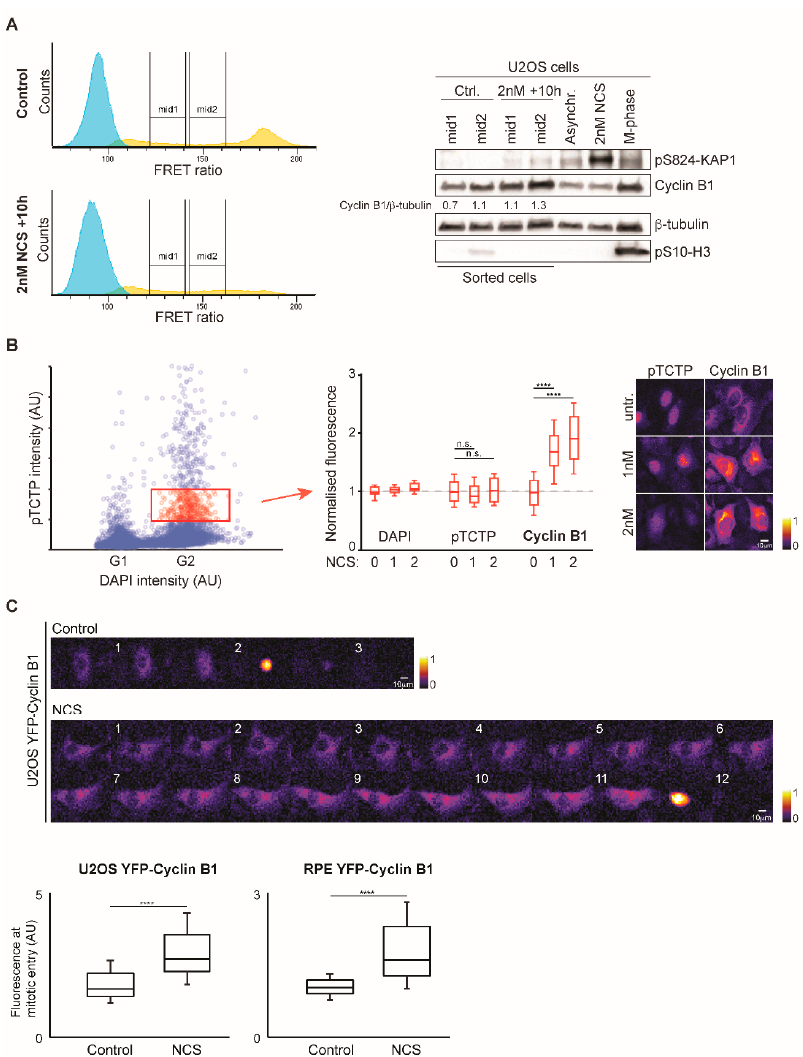
Figure 3. Cells recovering from a DNA damage checkpoint contain increased level of Cyclin B1. ( A ) 10 h after being exposed to 2 nM NCS, cells were sorted according to their level of PLK1 activity. Two fractions, defined “mid1” and “mid2”, were collected for both control and NCS-treated cells. All samples were treated with 10 μ M S-trityl-L-cysteine (STLC) 4 h before the sorting. After the sorting, cells were pelleted, lysed in Laemmli sample buffer and analyzed by Western blot. Unsorted cells, either untreated, treated with 2 nM NCS or treated with 10 μ M STLC and subjected to mitotic shake off were included as a reference. Phosphorylation of histone H3 was used as a marker of mitotic cells, whereas phosphorylation of KAP1 (a direct target of the ataxia-telangiectasia mutated (ATM) kinase) was used to indicate activation of the DNA damage response. ( B ) 10 h after treatment with 2 nM NCS, U2OS cells were fixed and stained with phosphorylated TCTP (pTCTP, a proxy for PLK1 activity) and Cyclin B1 antibodies. Integrated intensities of DAPI and pTCTP were used to identify early G2 cells (red dots, enclosed by the red rectangle), whose levels of DAPI, pTCTP and cyclin B1 are plotted in the graph on the right. Values are normalized to the average intensity in the absence of NCS. Representative images are showed to the right. ( C ) U2OS and RPE1 cells carrying an endogenously YFP-tagged Cyclin B1 were treated with 1 nM NCS and followed during the recovery phase by live cell microscopy. Graphs present the means of the integrated intensity of nuclear Cyclin B1-YFP. 34 to 92 cells were quantified for each condition and error bars represent the standard deviation. Representative images of U2OS cells are shown on top of the panel. Timestamps on the top-left corner indicate hours post damage induction. n.s. (not significant) indicates p > 0.05, whereas **** indicates p < 0.0001 using Student’s T